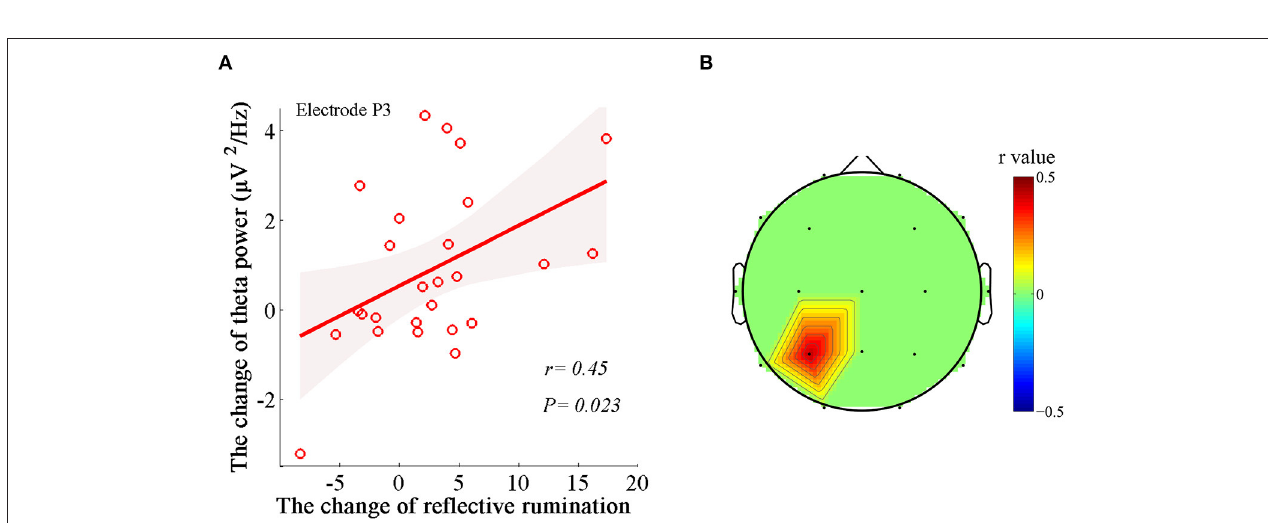
FIGURE 4 | Associations between the changes in the dynamics of EEG theta rhythm and the changes in reflective rumination. (A) Positive correlation between 1 theta power in the left parietal region (electrode P3) and 1 RRS-R ( r = 0.45, P = 0.023). Shaded areas delineate the confidence interval of 95%. (B) Topological correlations between 1 theta PLV and 1